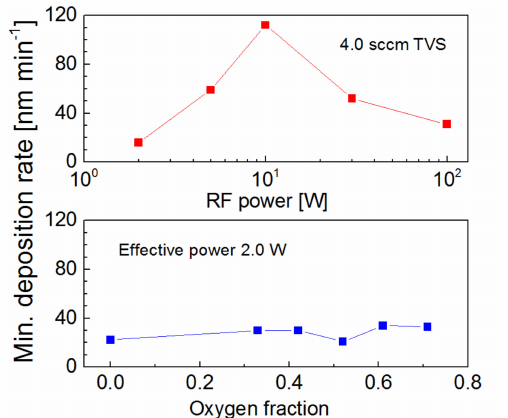
Figure 4. Minimum deposition rate dependent on RF power for plasma nanocoatings deposited from pure TVS at a flow rate of 4.0 sccm (upper part) and dependent on oxygen fraction for nanocoatings deposited from the TVS / O 2 mixture at an e ff ective power of 2.0 W (bottom